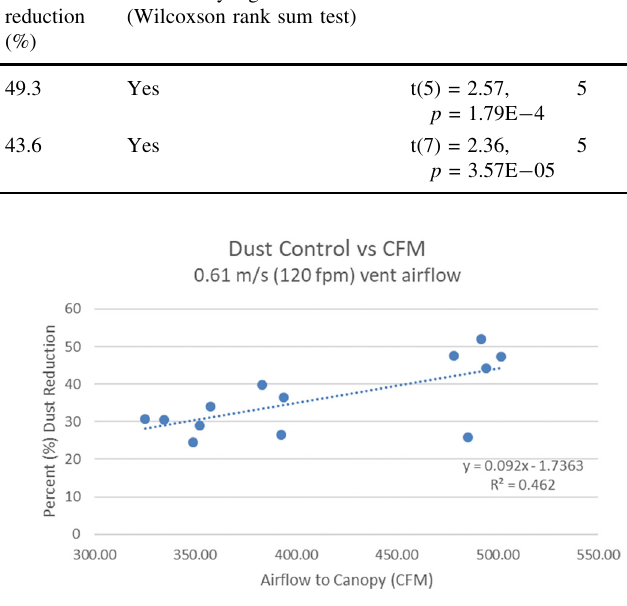
Table 13 Summary of dust control efficiency for the CAC at 10-in. height underneath the canopy using Large Fan #3 Velocity Average canopy-off ratio (m/s|fpm) (canopy/upwind)